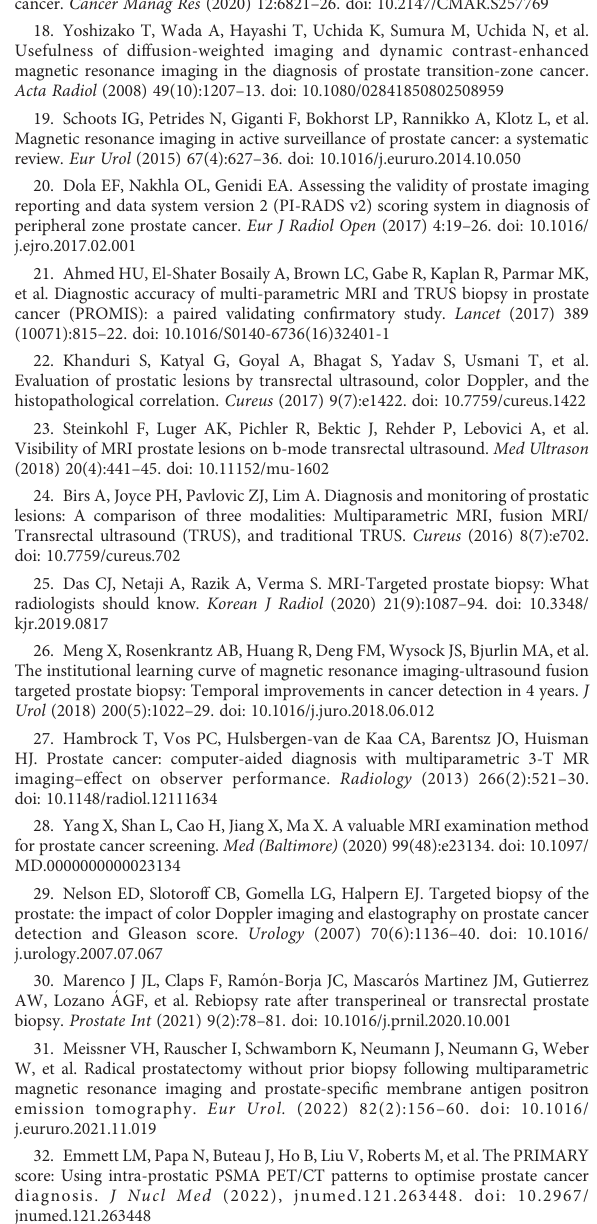
Blood fl ow plethysmogram of benign prostatic hyperplasia. (A) Blood fl ow plethysmogram of benign prostatic hyperplasia in cross section; (B) Blood fl ow plethysmogram of benign prostatic hyperplasia in longitudinal section;